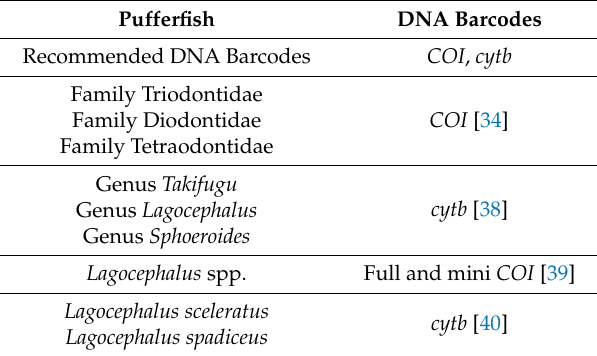
Table 5. Commonly used DNA barcodes in Pufferfish.